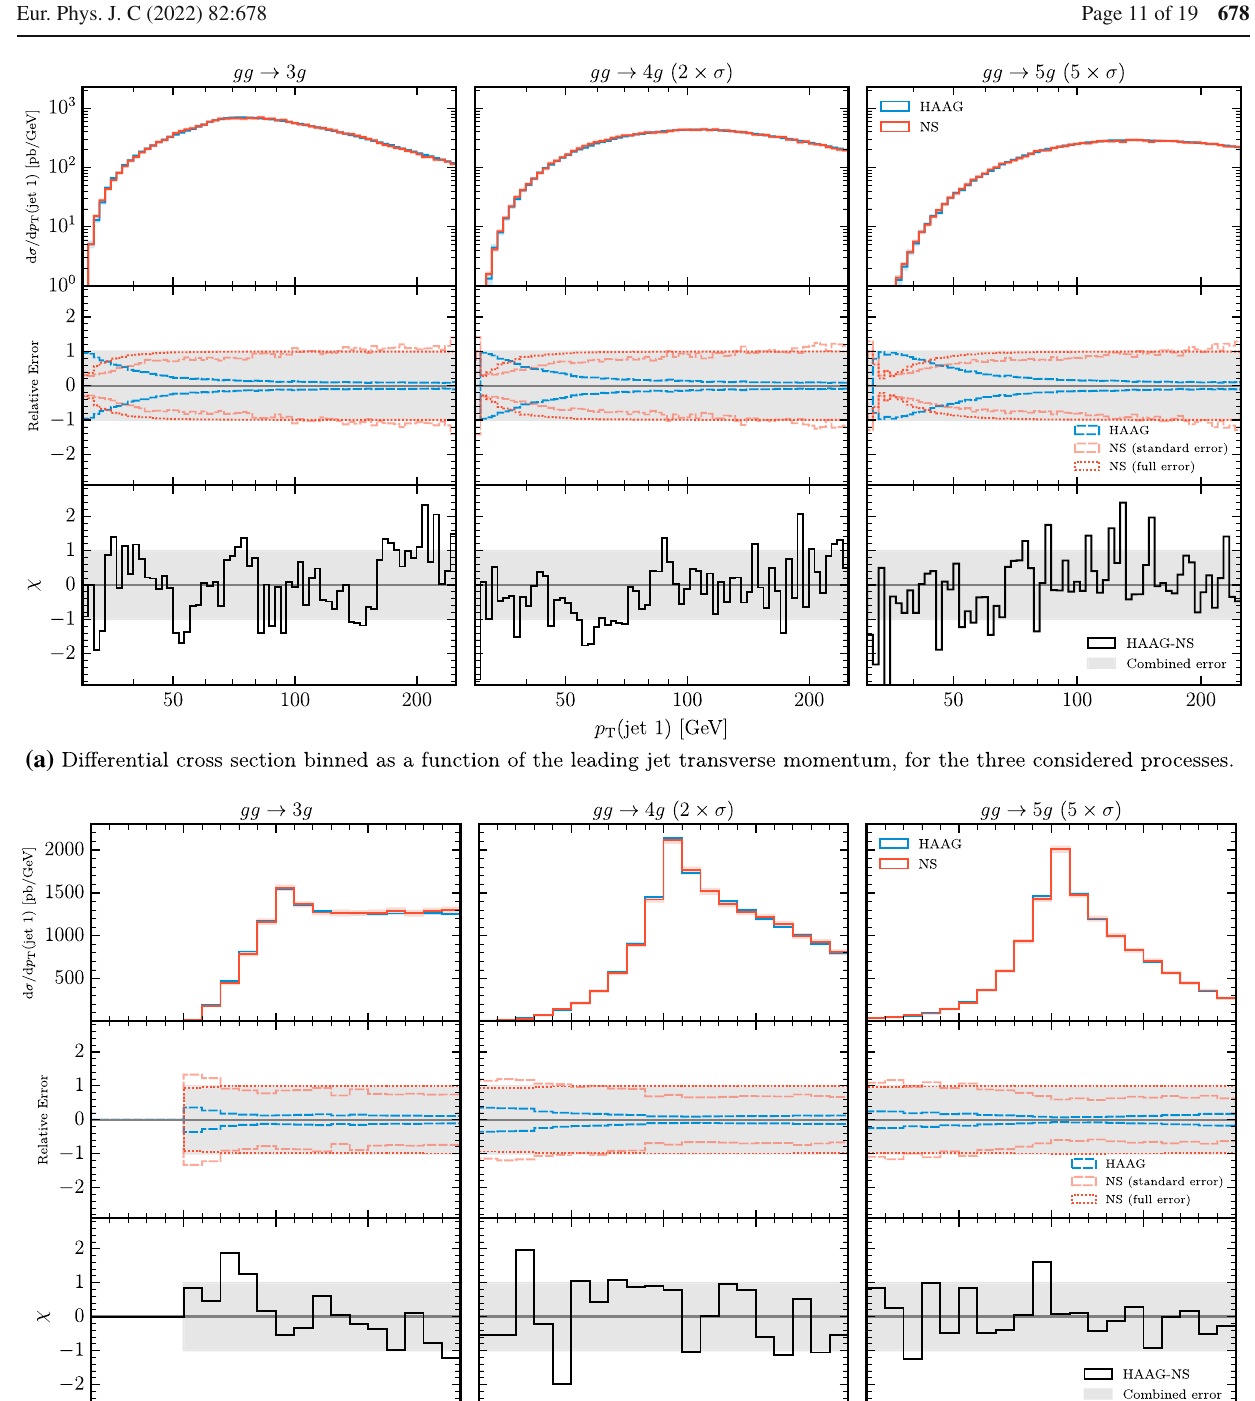
deviation. The deviation plot has been normalised such that χ = 1 corresponds to an expected 1 σ deviation of a Gaussian distribution. Note that for illustrative purposes the cross sections for the four- and five-gluon processes have been scaled by global